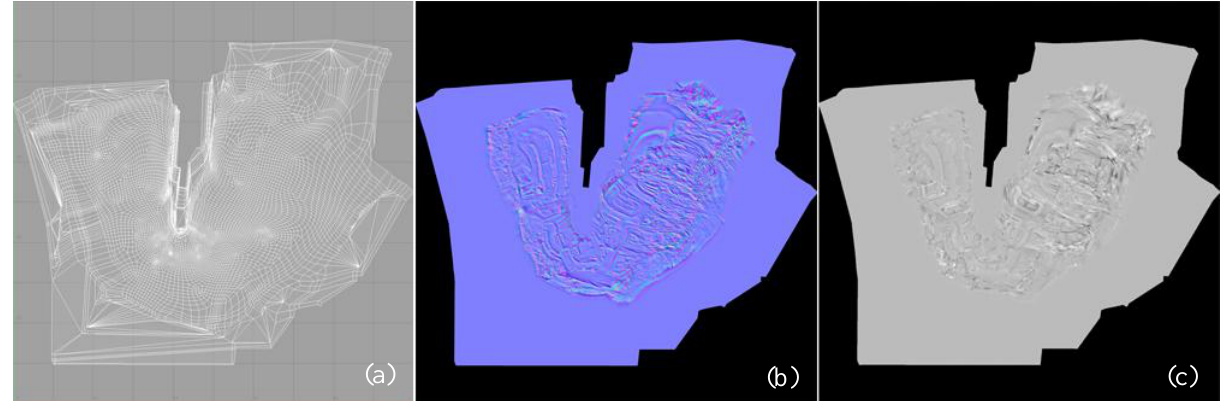
Figure 5. (a) The u,v reference system. (b) Normal map. (c) Displacement